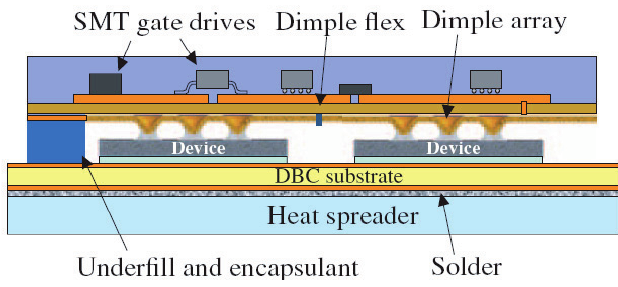
Fig. 7. Dimple array interconnexion (CPES – 2004).